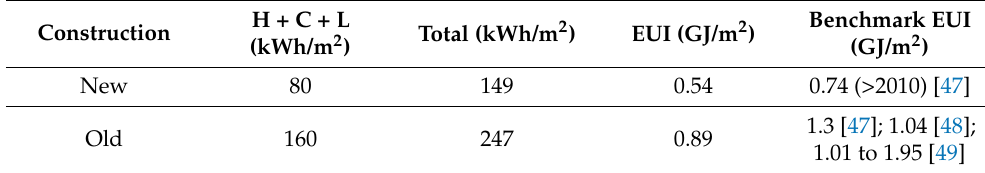
Table 4. Calibration of the model EUI with published benchmark data of